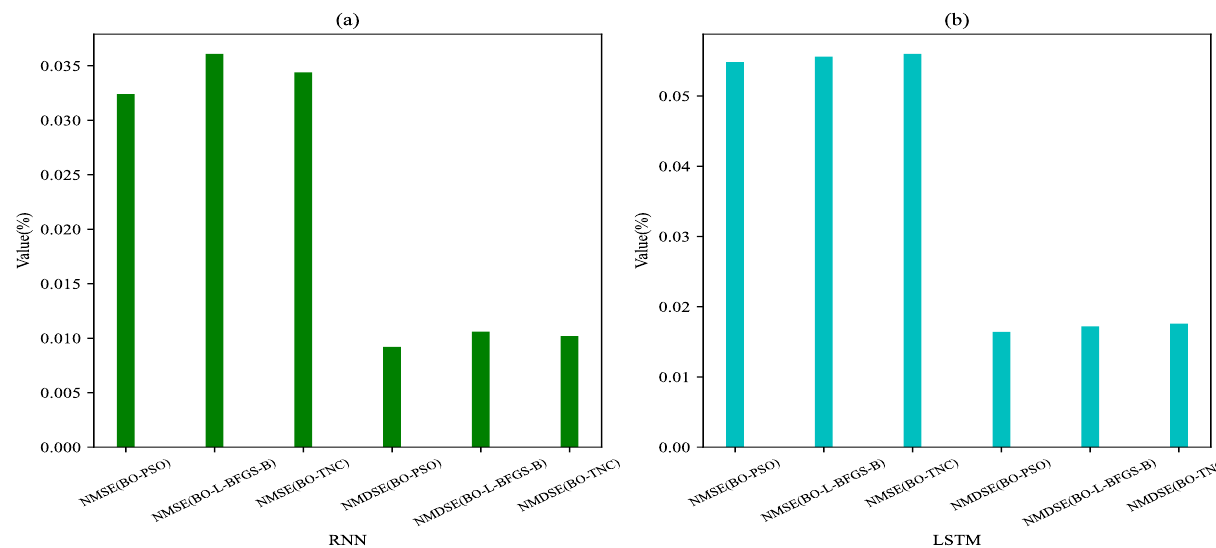
Figure 8. Comparison of values of NMSE and NMDSE. ( a ) Values of NMSE and NMDSE of RNN models optimized with the BO-PSO, BO-L-BFGS-B and BO-TNC ( b ) Values of NMSE and NMDSE of LSTM models optimized with the BO-PSO, BO-L-BFGS-B and